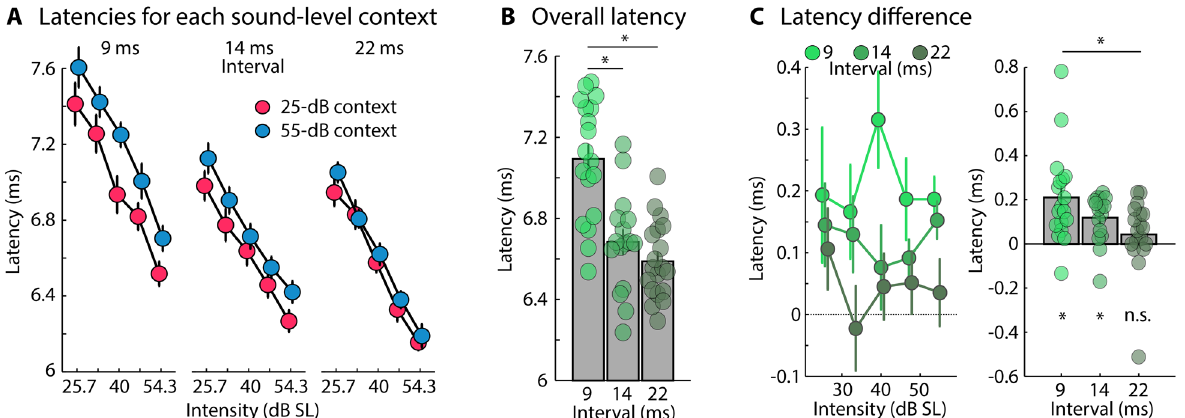
Figure 3. Neural adaptation to sound-level context for different click presentation rates. ( A ) Wave V latencies for target clicks with different sound levels in two sound-level contexts (25-dB SL and 55-dB SL contexts) and for different click presentation rates (9 ms [Experiment II], 14 ms [Experiment III], 22 ms [Experiment IV]). ( B ) Overall Wave V latency for target clicks presented at different presentation rates, independent of sound level and context. ( C ) Latency difference between sound-level contexts (55-dB context minus 25-dB context) for each target click sound level (left) and averaged across target click sound levels (right). Asterisks below the bar graphs indicate a significant difference from zero (i.e., between the two contexts). Error bars reflect the standard error of the mean. *p ≤ 0.05, n.s. not